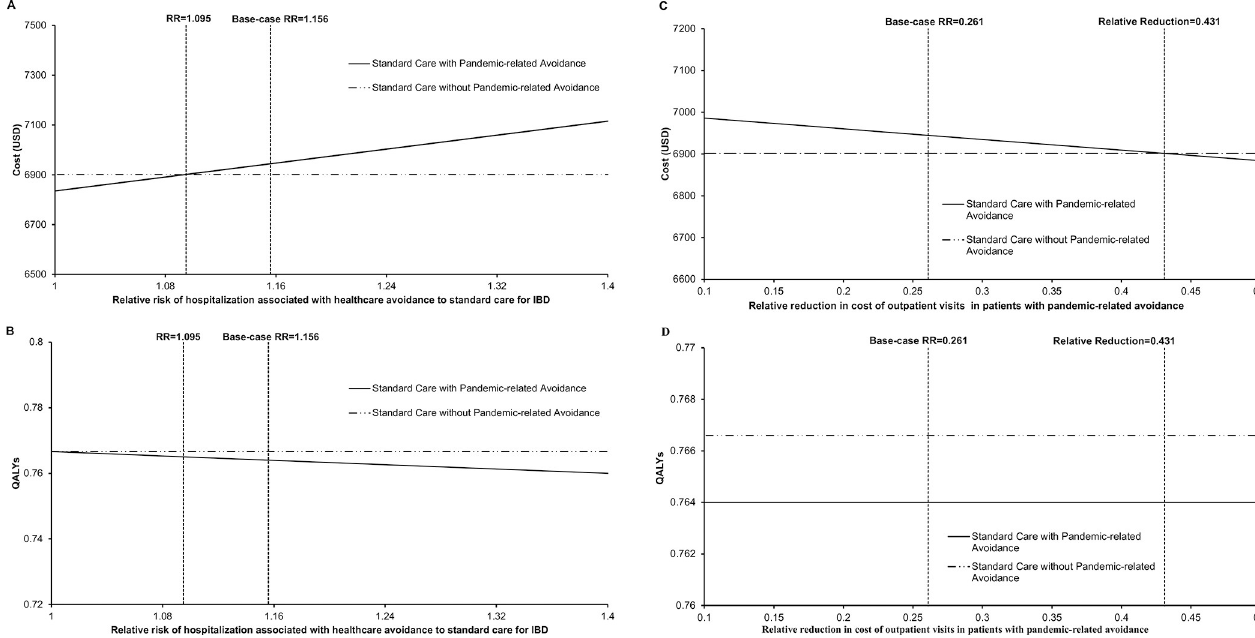
Fig 2. A, B. One-way sensitivity analysis on risk of hospitalization. C, D. One-way sensitivity analysis on outpatient cost reduction. IBD, inflammatory bowel disease; QALY, quality-adjusted